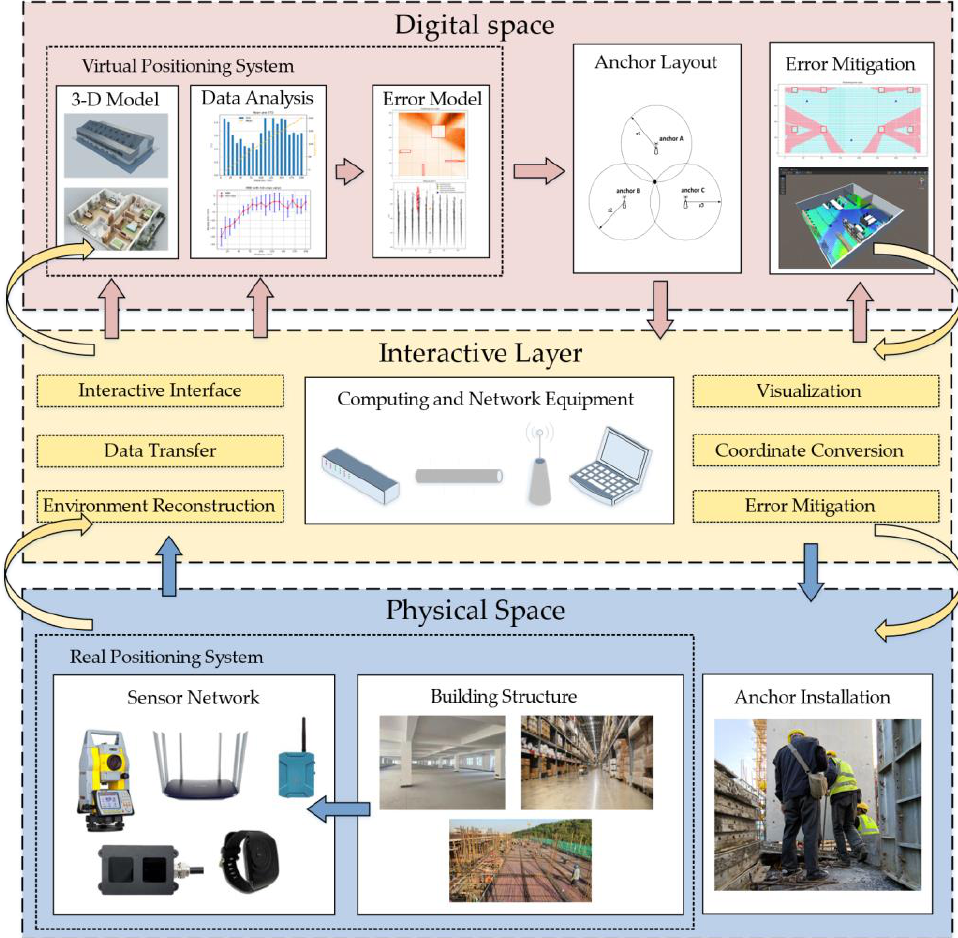
Figure 1. Architecture of the system.